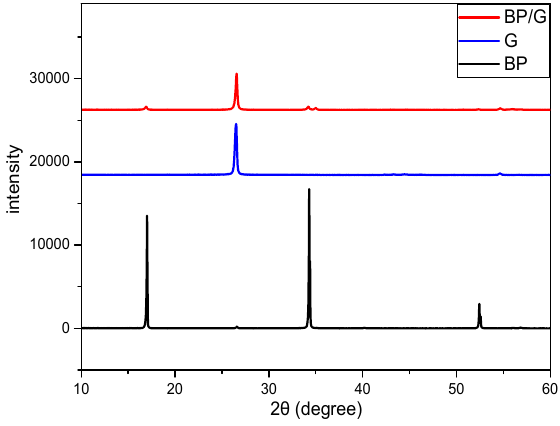
Figure 2. XRD spectra of BP, G, BP/G composite material.